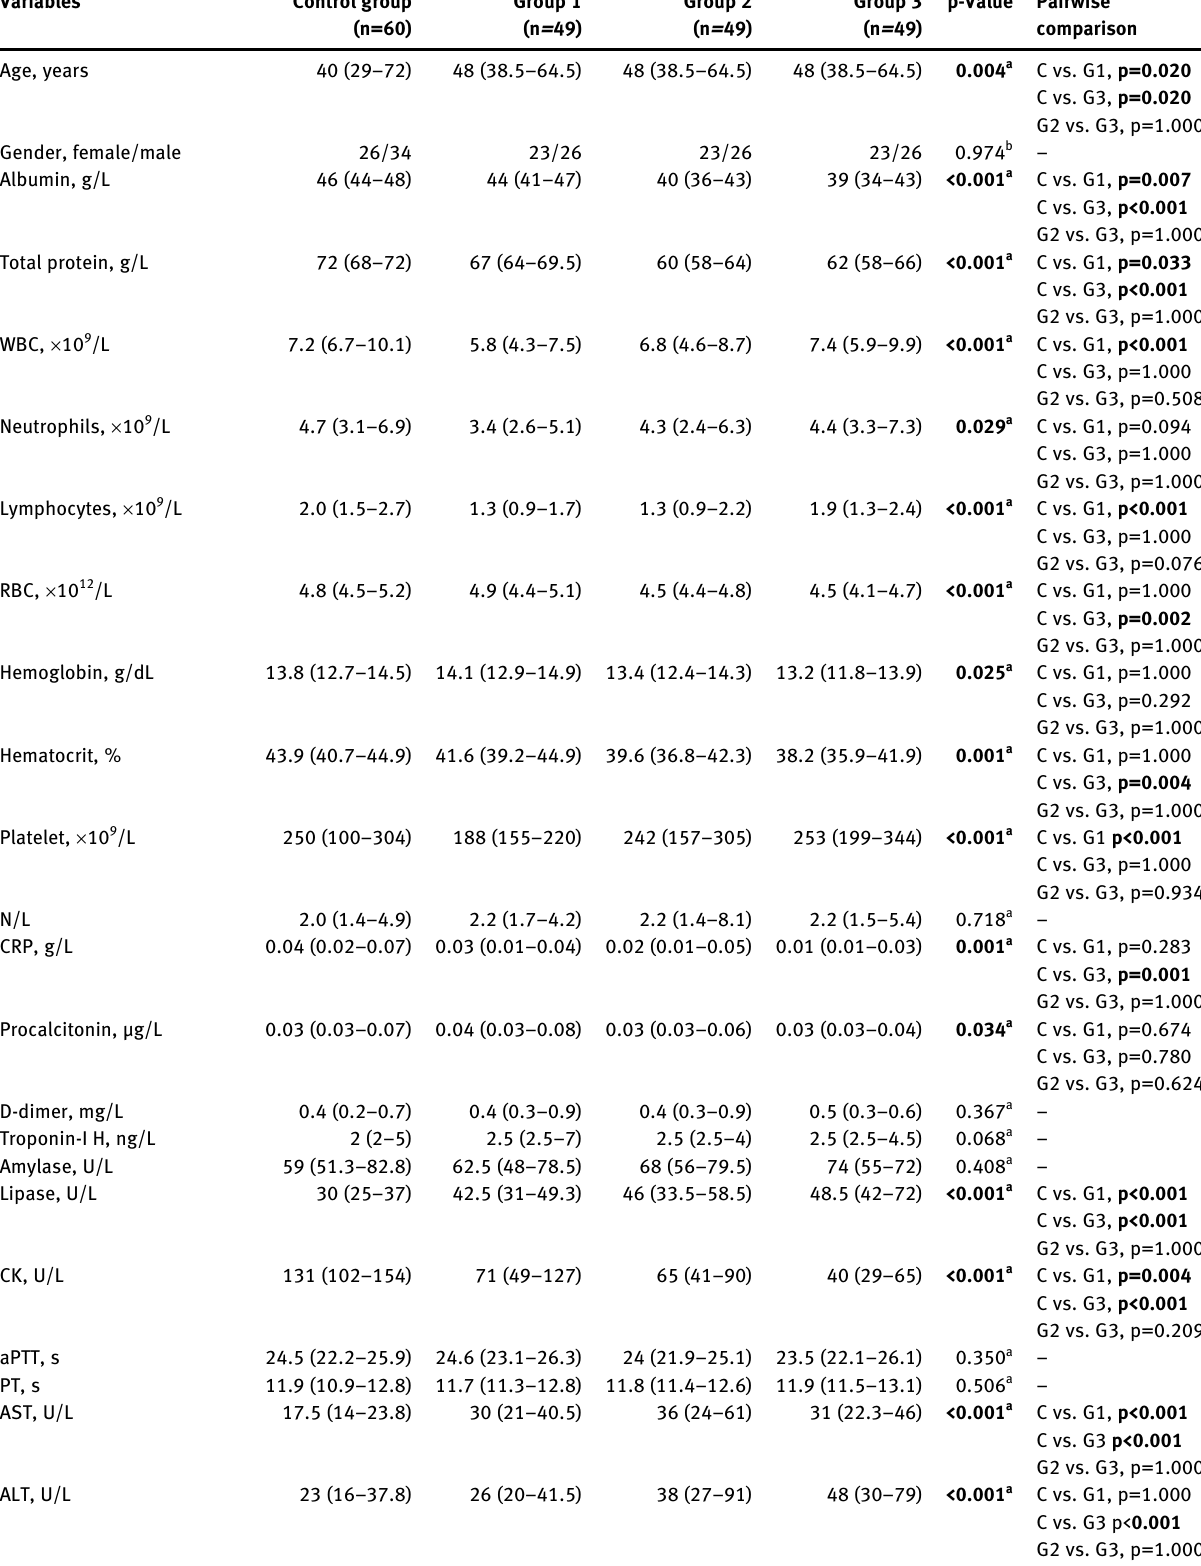
Table  : Blood routine parameters characteristics of patients group according to